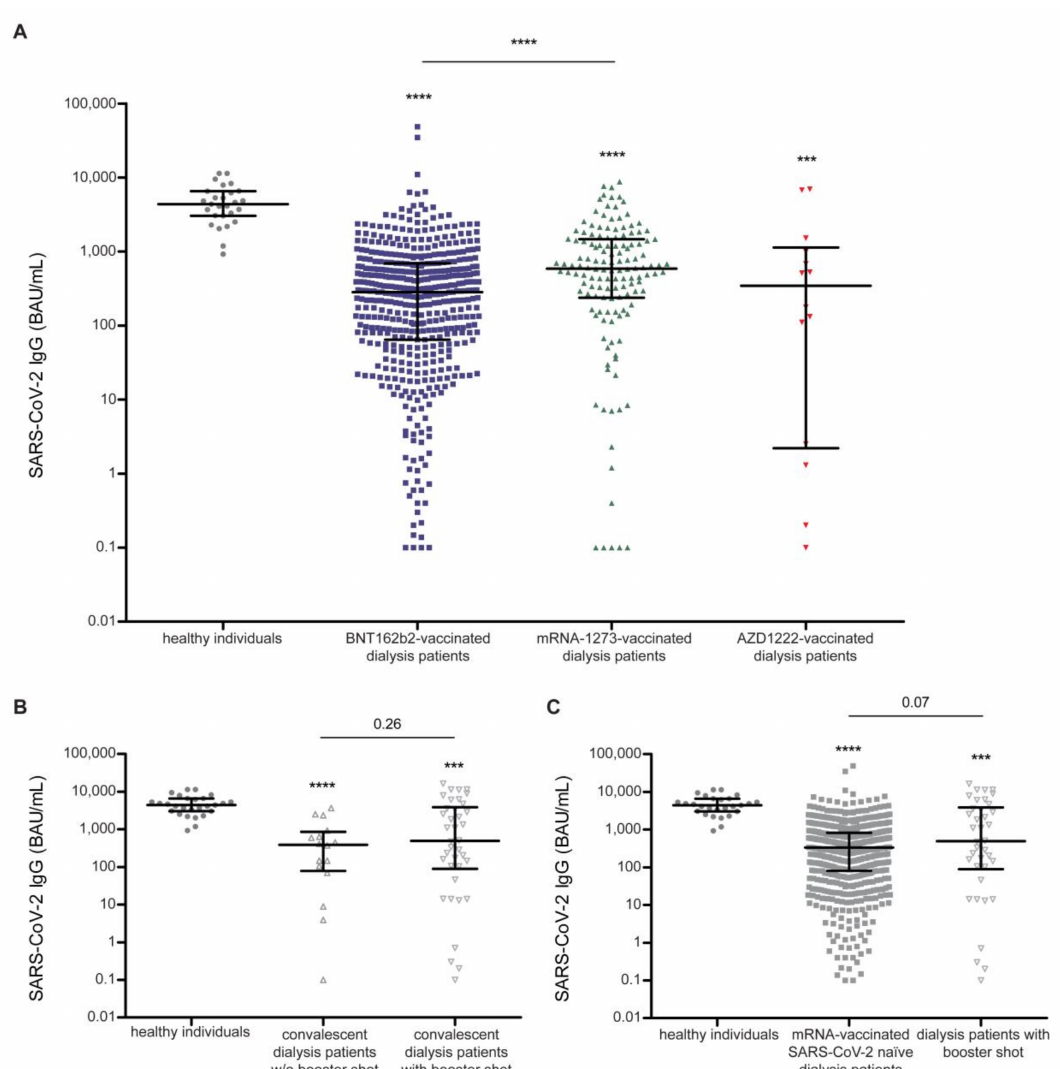
Figure 2. Vaccine- and infection-induced humoral response quantified by anti-SARS-CoV-2 IgG titers in dialysis patients compared to vaccinated healthy individuals. ( A ) Vaccine-induced anti-SARS- CoV-2 IgG titers in dialysis patients differ significantly between dialysis patients immunized by BNT162b2, mRNA-1273, and AZD1222 compared to the reference cohort of mRNA-1273 vaccinated healthy individuals. ( B ) Infection induced anti-SARS-CoV-2 IgG titers in convalescent dialysis patients with (w) and without (w/o) booster shot immunization using BNT162b2 mRNA are reduced compared to vaccine-induced titer in healthy individuals. ( C ) Booster shot-induced anti-SARS-CoV-2 IgG titers in SARS-CoV-2-recovered dialysis patients are elevated compared to mRNA vaccine- induced titers in SARS-CoV-2-naïve dialysis patients. Vaccines used: BNT162b2 (BioNTech/Pfizer, Mainz, Germany/New York, NY, USA), mRNA-1273 (Moderna, CA, Unites States), and AZD1222 (AstraZeneca/University of Oxford, Cambridge/Oxford, UK) in dialysis patients; mRNA-1273 (Moderna, CA, Unites States) in healthy individuals. A Kruskal-Wallis test across all groups was used to indicated differences to healthy individuals. Mann–Whitney U test was used to indicated differences between two groups (*** p < 0.001 and **** p < 0.0001). Data are represented as median ± interquartile range and each patient is depicted by a single dot. IgG: immunoglobulin G; BAU: binding antibody unit; SARS-CoV-2: severe acute respiratory syndrome coronavirus type